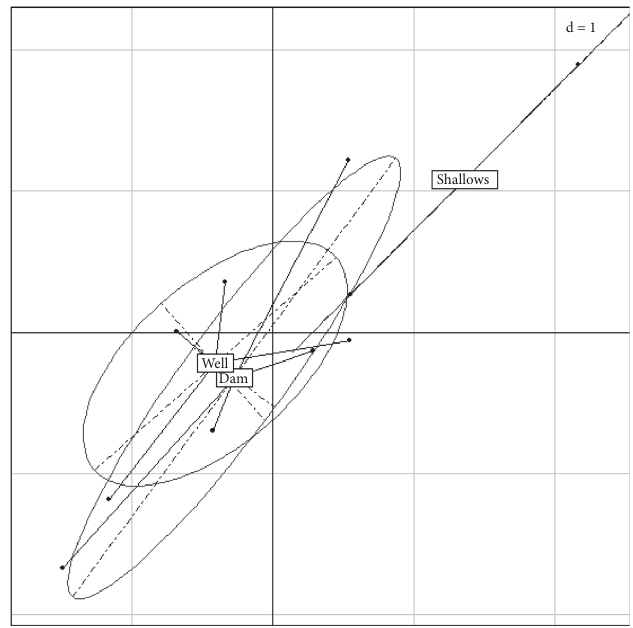
Figure 6: Classification of sampling locations according to the set of microorganisms.